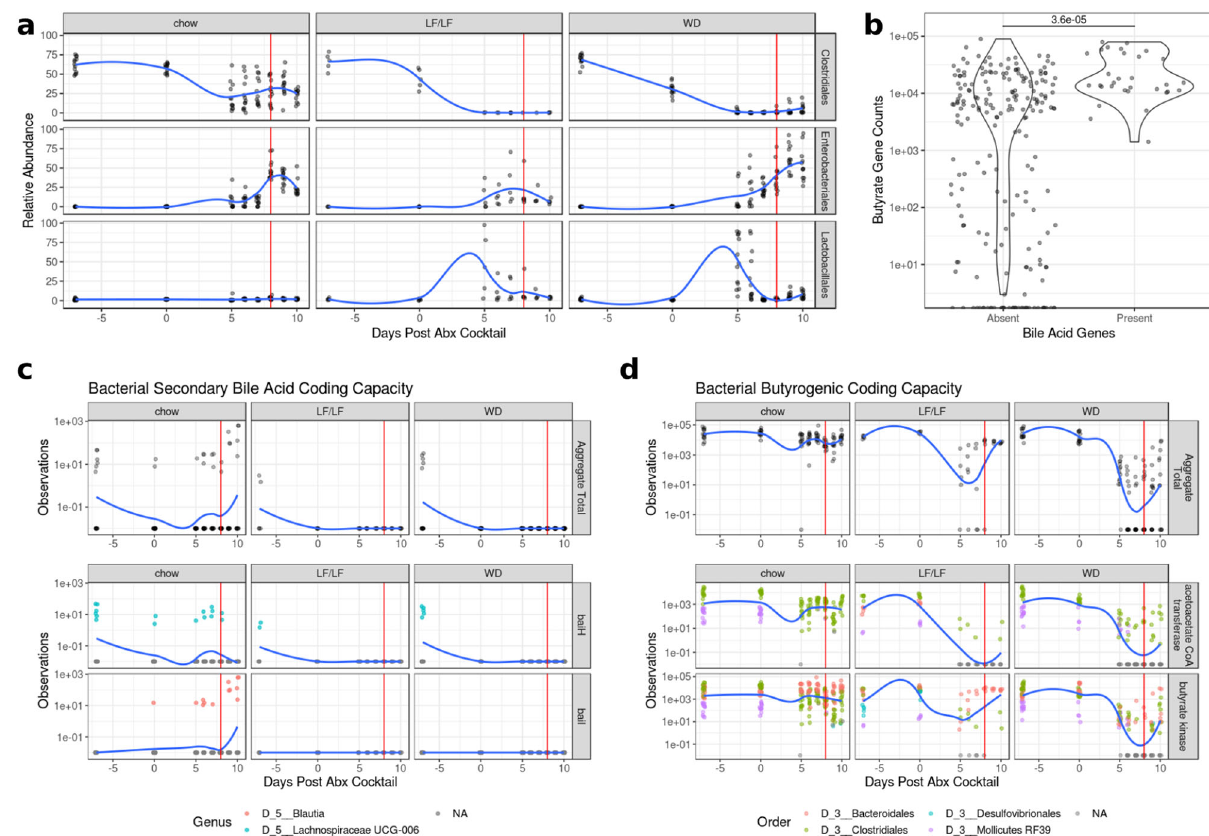
Fig. 7 Changes in key taxa, and secondary bile acid and butyrate coding capacity during the CDI protocol. The vertical red line in a , c , and d indicate the day of C. dif fi cile infection. All trend lines were fi t using local polynomial regression. a Relative abundance of key bacterial orders during antibiotic treatment and infection. A summary of signi fi cant differences of these taxa across diets is in Supplementary Fig. 4. b Violin plots of abundance of butyrate genes from PICRUSt2 analysis binned by the presence of secondary bile acid-producing genes (Wilcoxon p < 0.001). c Time course of the coding capacity of secondary bile acid genes. The top row shows the total capacity of each sample ( baiH and baiI ) while the bottom two rows show speci fi c taxa contributions of key genes in the Bai operon. d Time course of the coding capacity of butyrate- producing genes by diet. The top row shows the total capacity as measured by but and buk genes while the bottom two rows show speci fi c taxa contributions of but and buk speci fi cally. Taxa with mean relative abundance < 0.01% were fi ltered from the